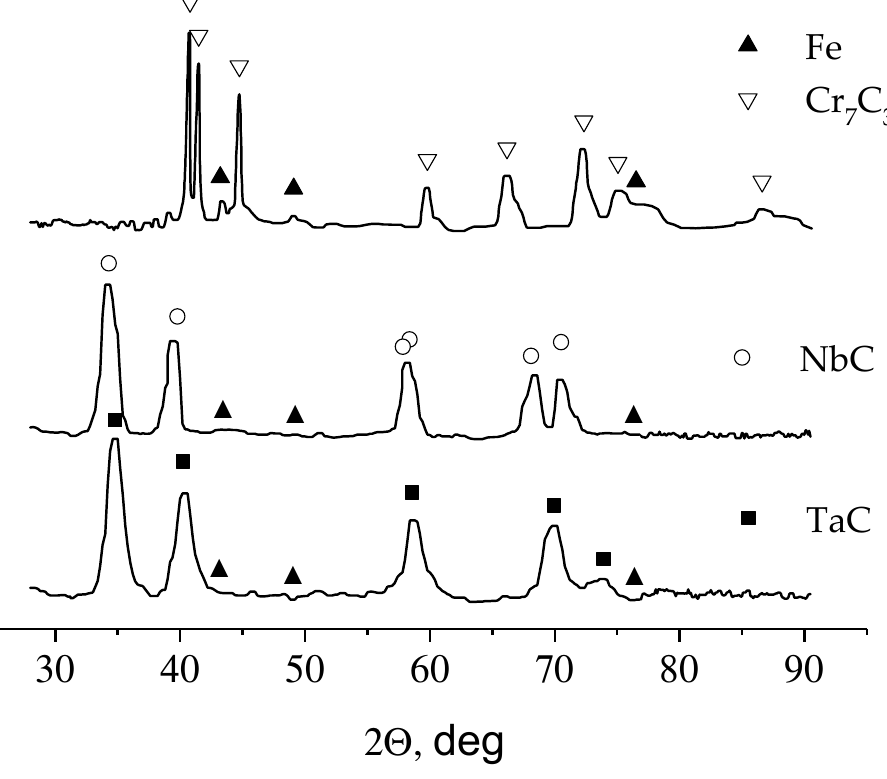
Figure 6. XRD patterns of the refractory carbide coatings on the St3 steel substrate (solid line), data points indicate the reference samples.